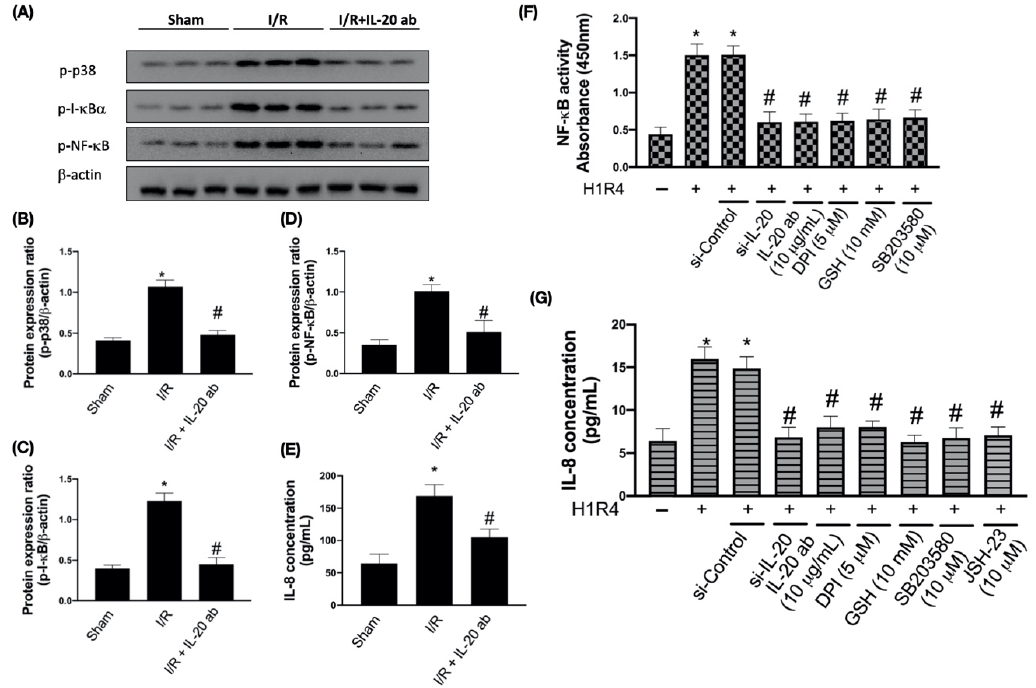
Figure 3. Interleukin (IL)-20 antibody mitigates ischemia/reperfusion (I/R)-induced inflammation by modulating nuclear factor kappa-light-chain-enhancer of activated B cells (NF- κ B) activity. Sprague Dawley rats receiving sham operation